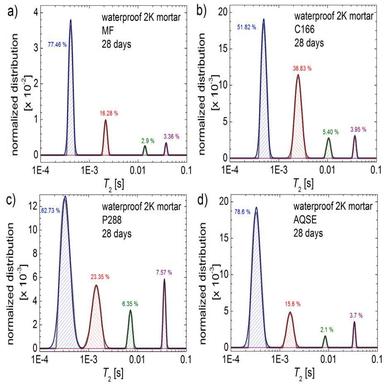
The normalized deconvolutions T2 distribution measured at 28 days after preparation for a) MF, b) C166, c) P288 and d) AQSE with the amount of 1 H content in each component.